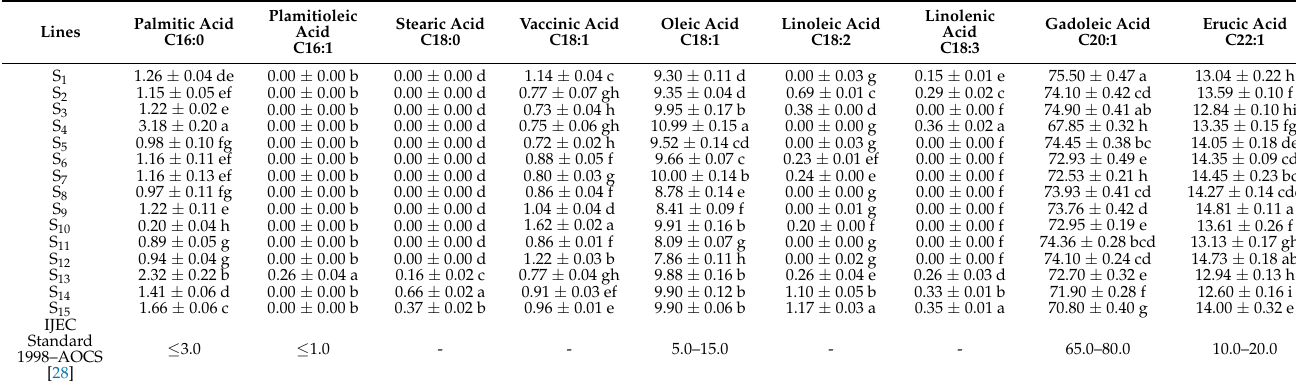
Table 3. Fatty acids contents of jojoba oils of the elite